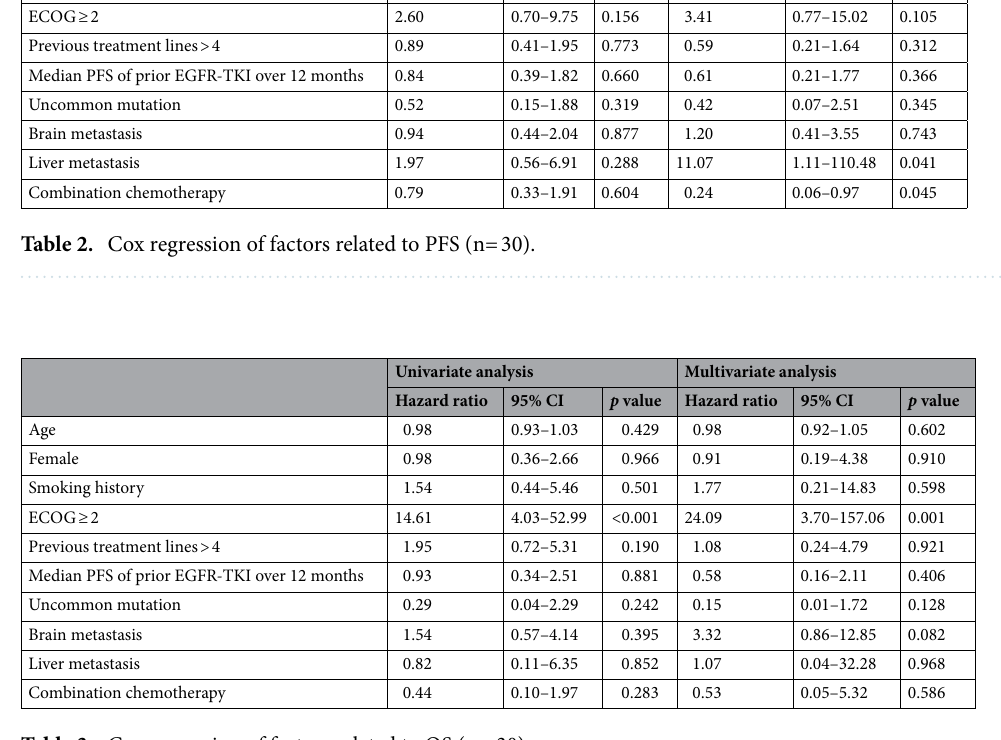
Table 3. Cox regression of factors related to OS (n =